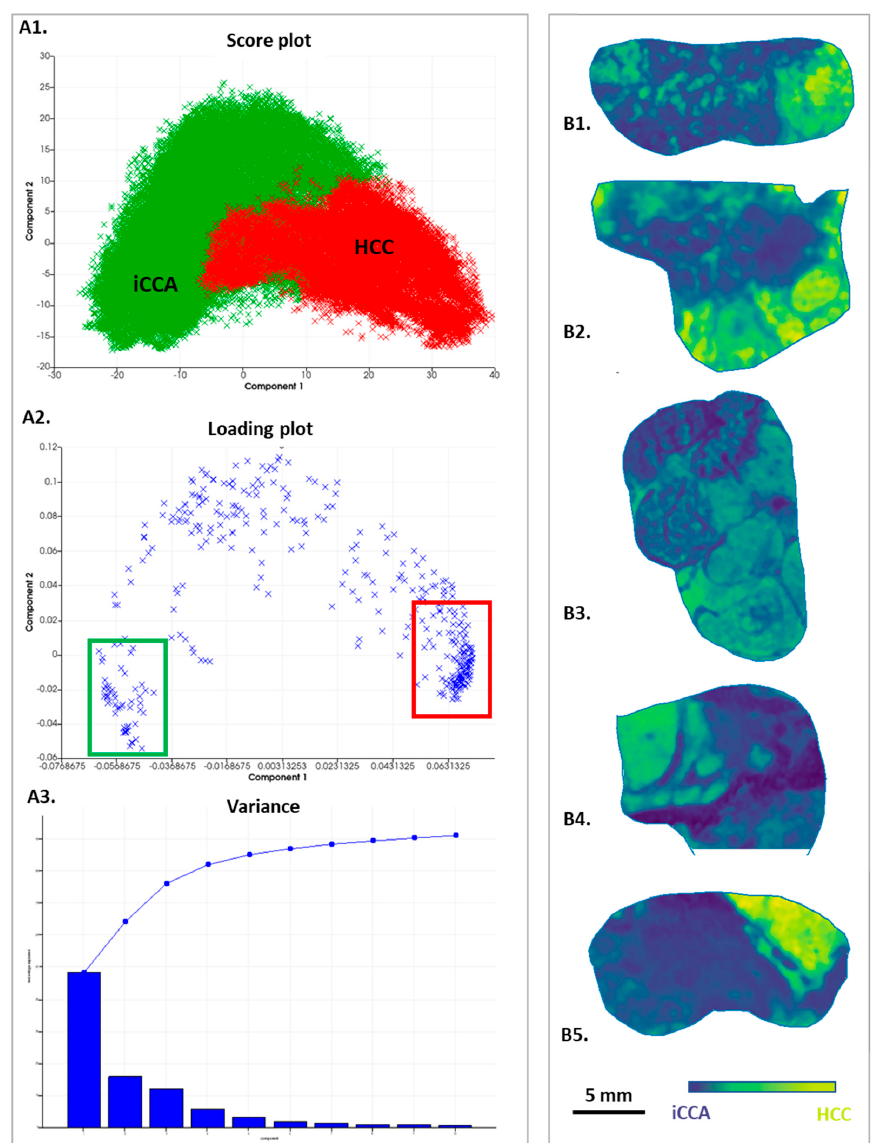
Figure 3. Principal component analysis of the 5 cHCC-CCA cases. ( A1 ): Score plot with iCCA component annotated in green and HCC component annotated in red. ( A2 ): Loading plot of PCA with speci fi c peptides of the 2 components boxed in green (iCCA) and red (HCC). ( A3 ): Variance of the PCA analysis. ( B1 – B5 ): Images of the 5 cases corresponding to the fi rst component within the deep blue iCCA component and in the yellow HCC component.